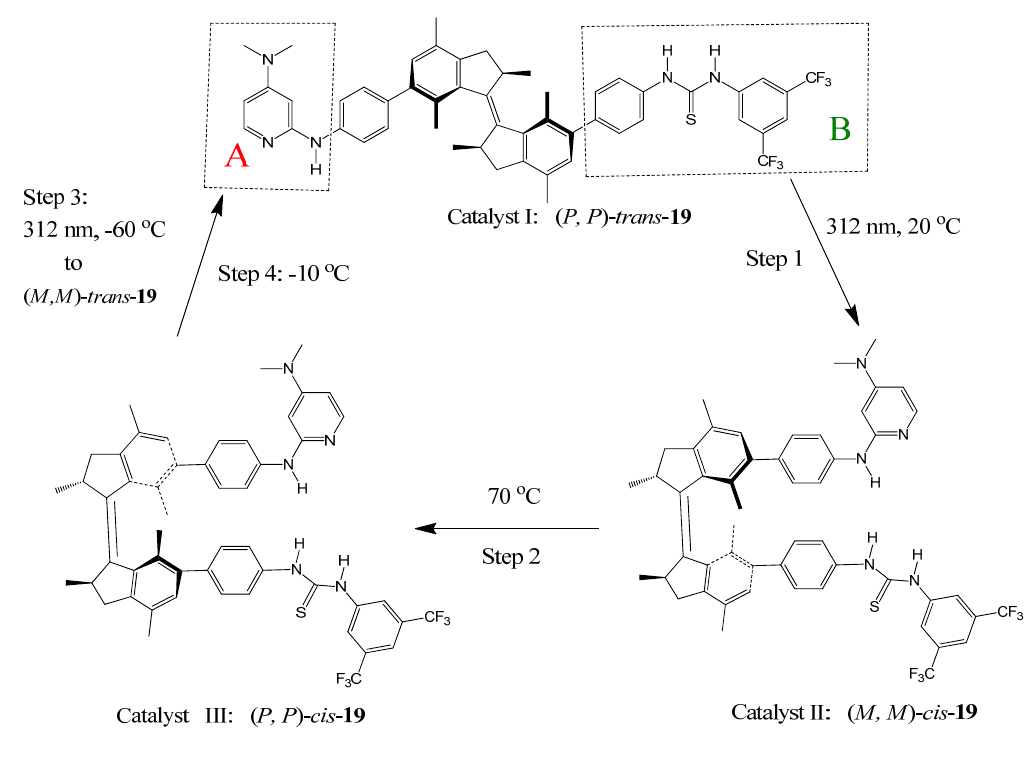
Figure 22. An integrated unidirectional light-driven molecular motor and bifunctional organocatalyst 19 (bottom) [98]. Adapted from reference